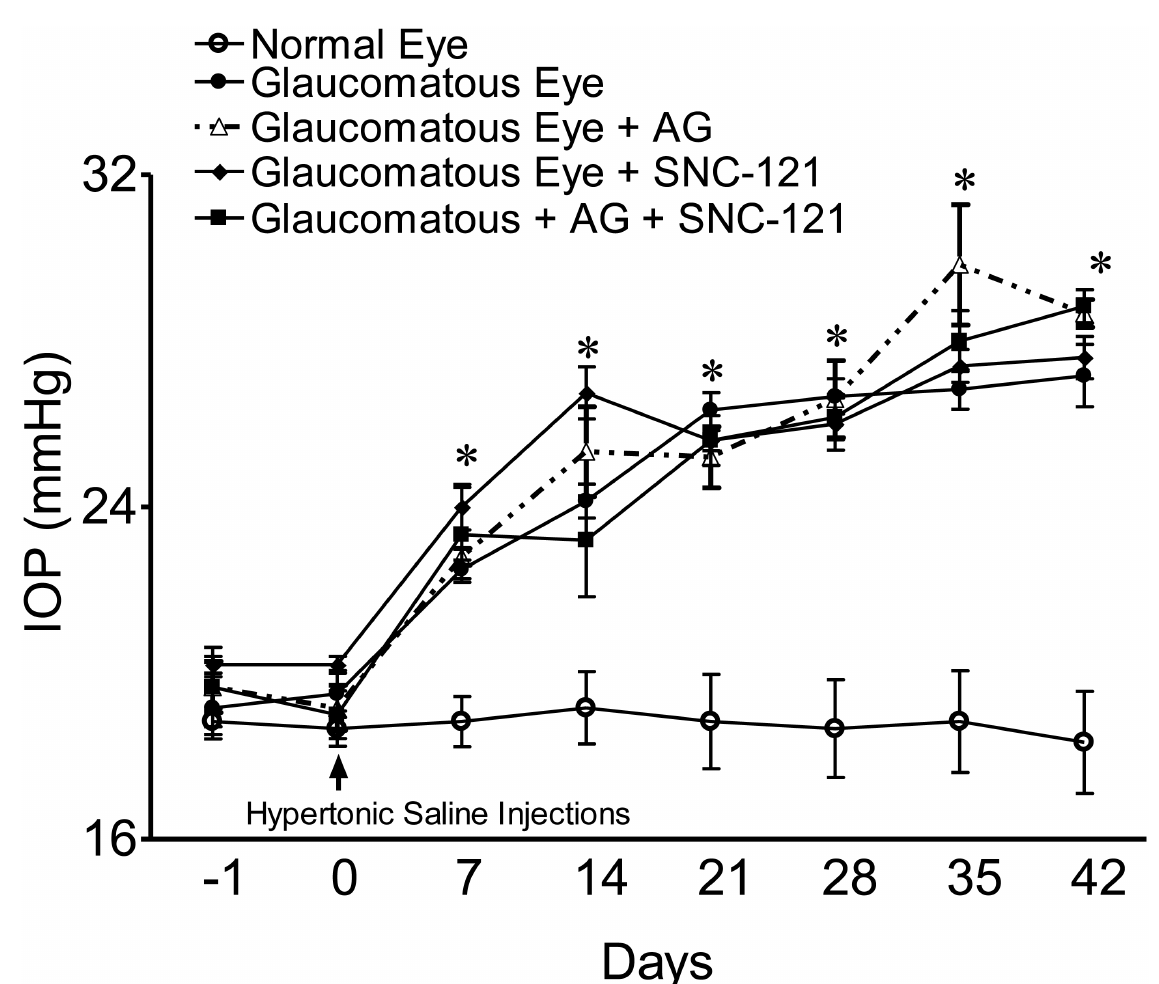
Figure 1. Intraocular pressure (IOP) measurements in normal and glaucomatous eyes. IOP of normal eyes and eyes from a chronic glaucoma model with and without AG (25 mg/kg; i.p.) and SNC-121 (1 mg/kg) treatment for 7 days (once daily) was measured as described in the Methods. IOP was elevated in one eye of Brown Norway rats by injecting approximately 50 m L of 2.0 M hypertonic saline, while the contralateral eye served as the control. Rats were maintained for up to 6 weeks post-surgery. Data are mean 6 SE. * P , 0.05; n=6–8 for each